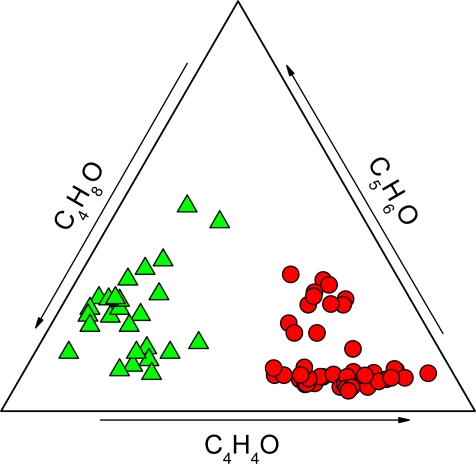
C4H4O-C5H6O-C4H8O triangular diagram. Symbols as in Figure 2.